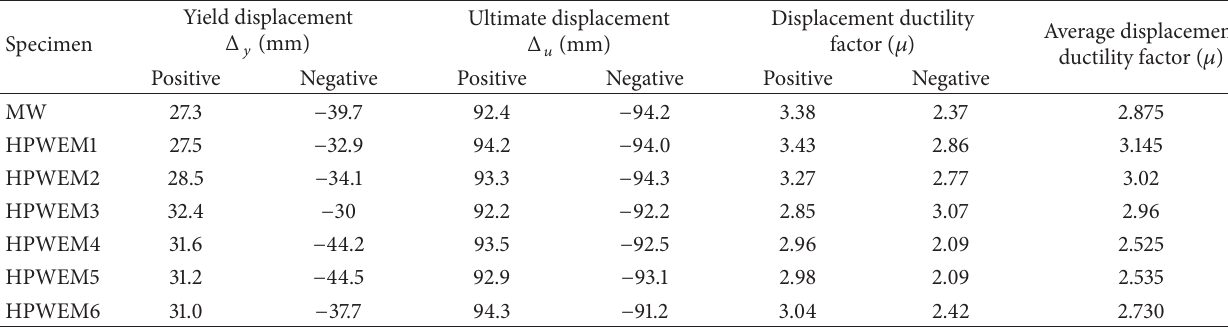
Table 4: Displacement ductility of the